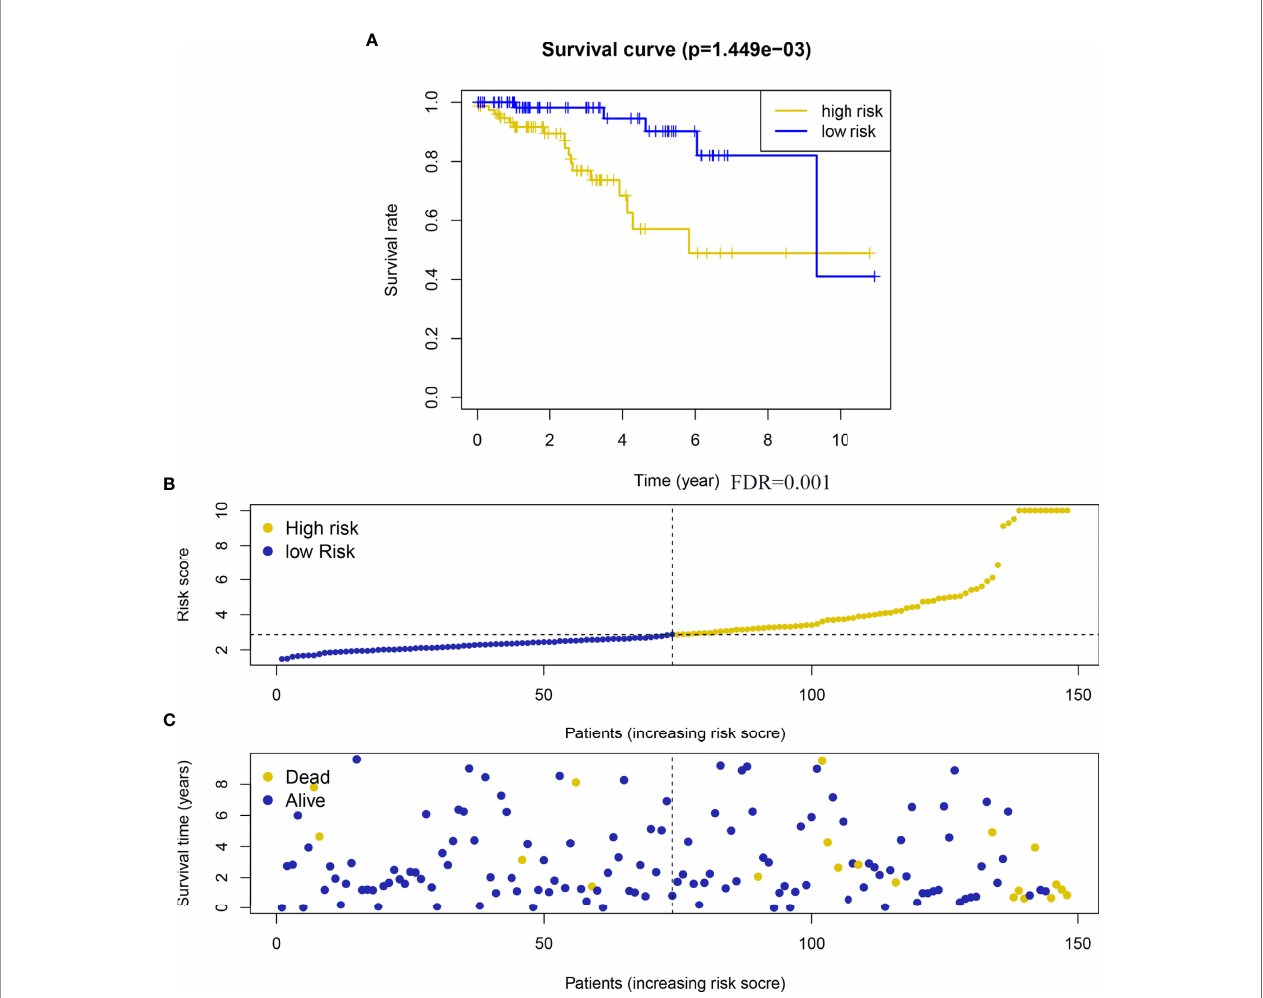
FIGURE 4 | A risk scoring system was derived from the prognostic 5 metabolism-related genes. (A) Heatmap of the 5 metabolism-related genes expression in HER2-positive breast cancer. (B) The risk score distribution on the basis of the 5 metabolism-related genes; (C) The vital status of 156 patients with HER2-positive breast cancer in high ‐ and low ‐ risk groups. A total of 156 HER2-positive samples were analyzed